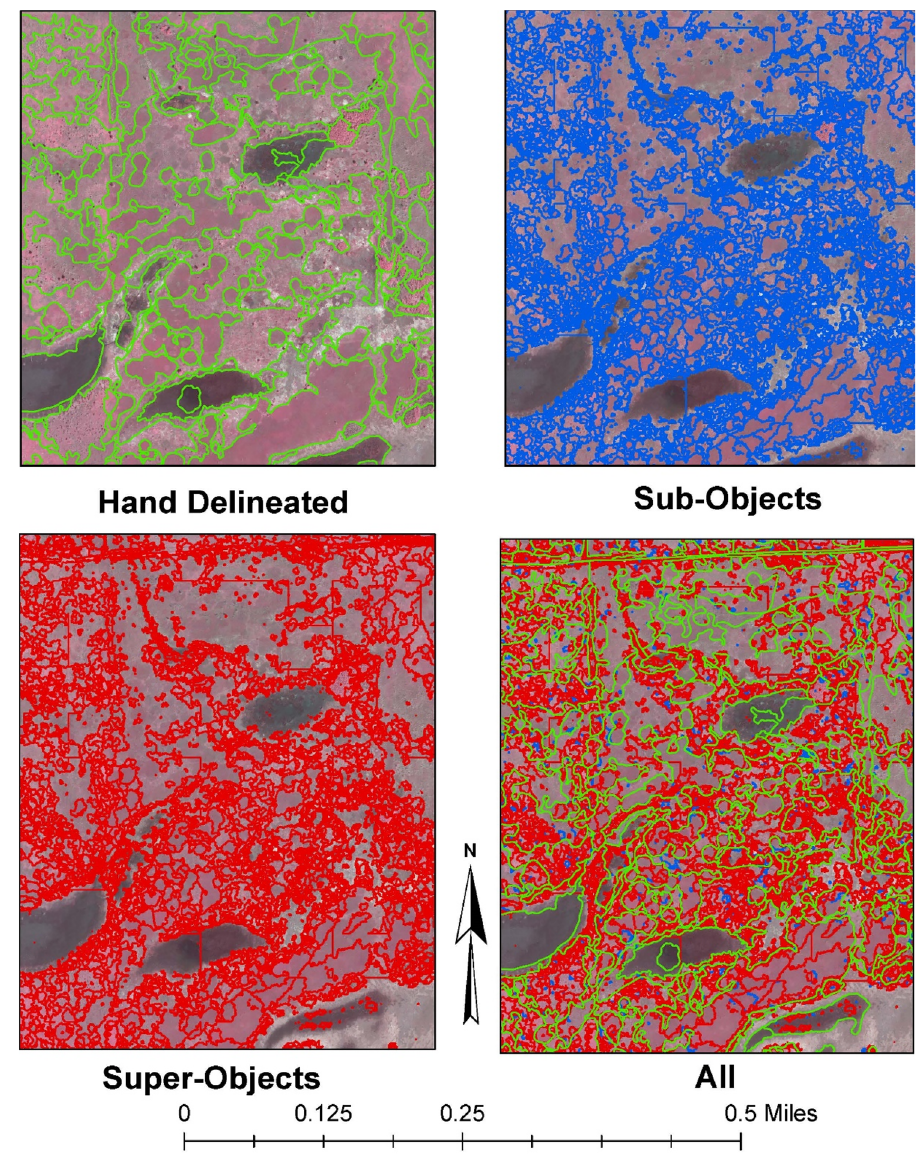
Figure 4. Automated and manual segmented comparison. Juxtaposition of hand delineated, sub-objects, and super-objects for segments generated using the Gabor features. Software: ArcMap